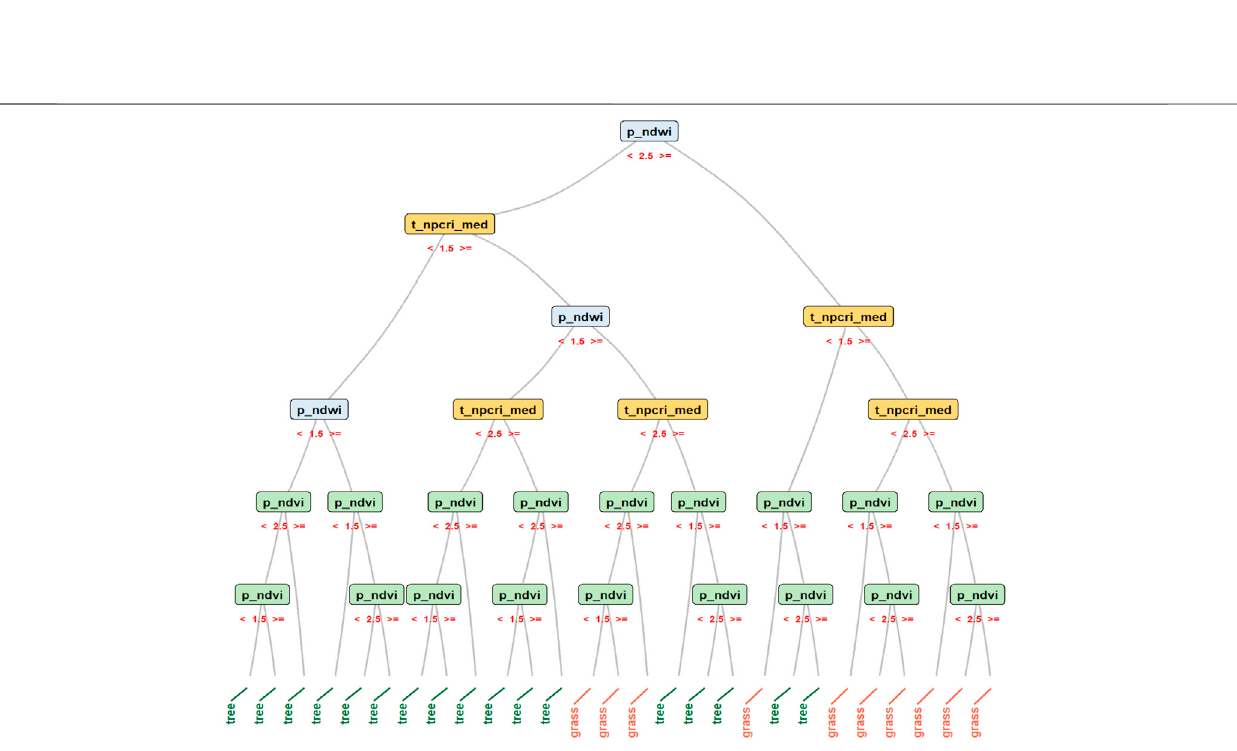
Frontiers in Environmental Science |